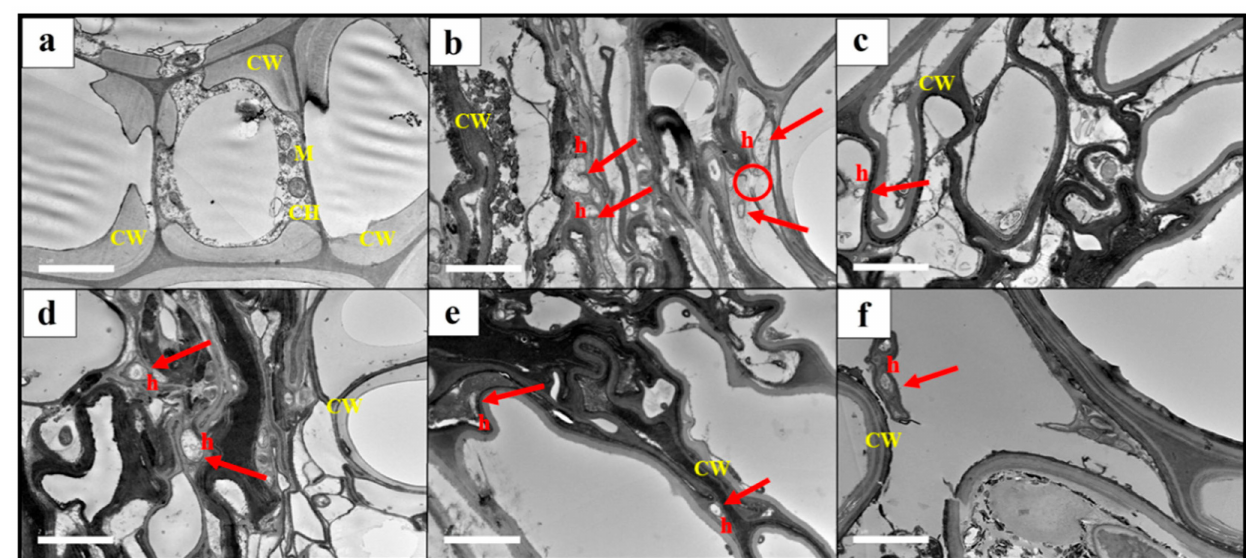
Figure 7. Examples of the TEM observation of root sections from rubber seedlings pretreated with Trichoderma suspensions and chemical fungicide after inoculation with Rigidoporus microporus for six months. ( a ) T1, a plant without any pretreatment and Rigidoporus microporus inoculum (as the negative control); ( b ) T2, a plant inoculated with Rigidoporus microporus but without any pretreat- ment (as the positive control); ( c ) T3, a plant pretreated with Trichoderma asperellum and inoculated with Rigidoporus microporus ; ( d ) T4, a plant pretreated with Trichoderma spirale and inoculated with Rigidoporus microporus ; ( e ) T5, a plant pretreated with a combination of Trichoderma asperellum + Trichoderma spirale and inoculated with Rigidoporus microporus ; and ( f ) T6, a plant pretreated with chemical propiconazole and inoculated with Rigidoporus microporus . CW: cell wall; CH: chloroplast; M: mitochondrion, and h: hyphae of Rigidoporus microporus (arrow). (Scale bar = 2 µ m; magnification: ×